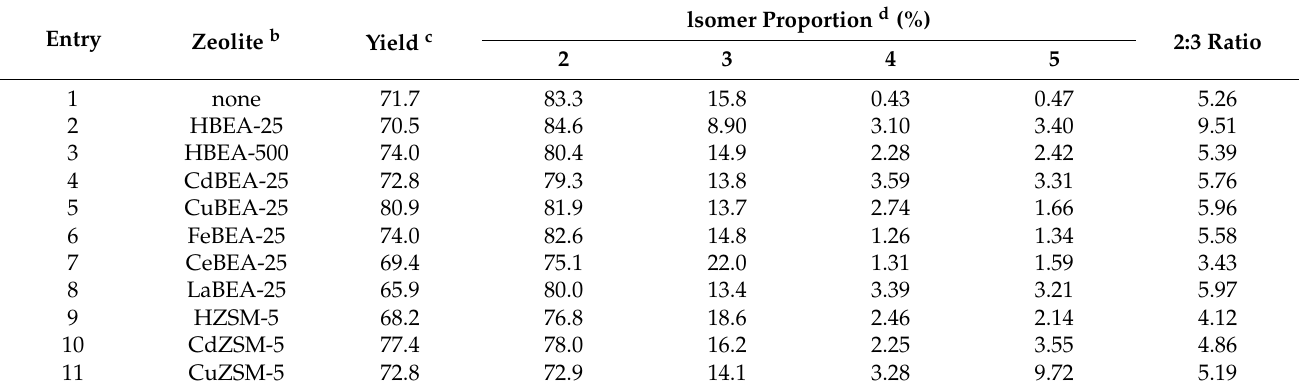
Table 3. The effect of zeolite type on the nitration of naphthalene with HNO 3 a